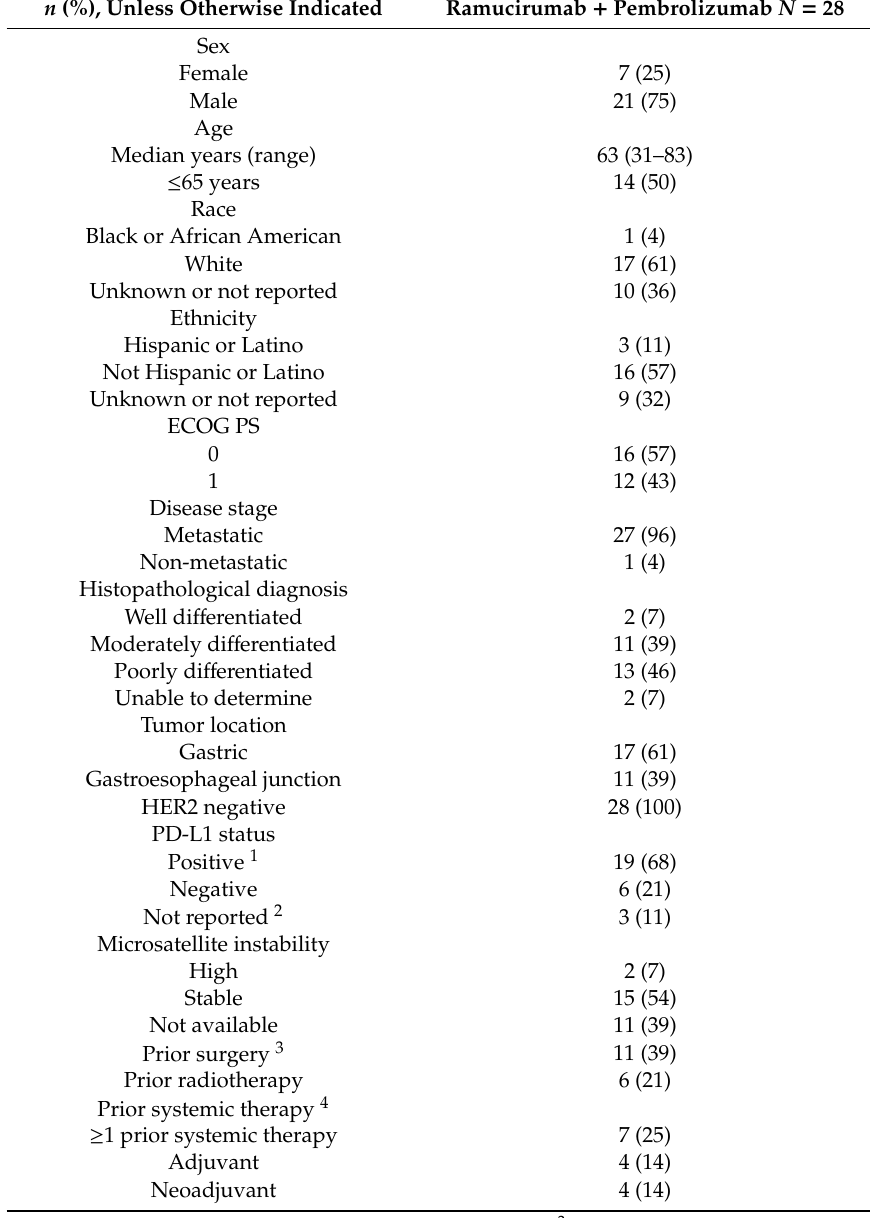
Table 1. Baseline demographic and clinical